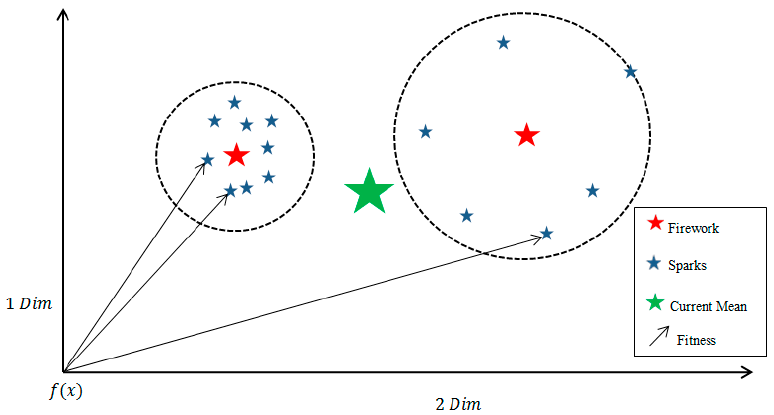
Figure 3. Current mean of the = fitness of the sparks.